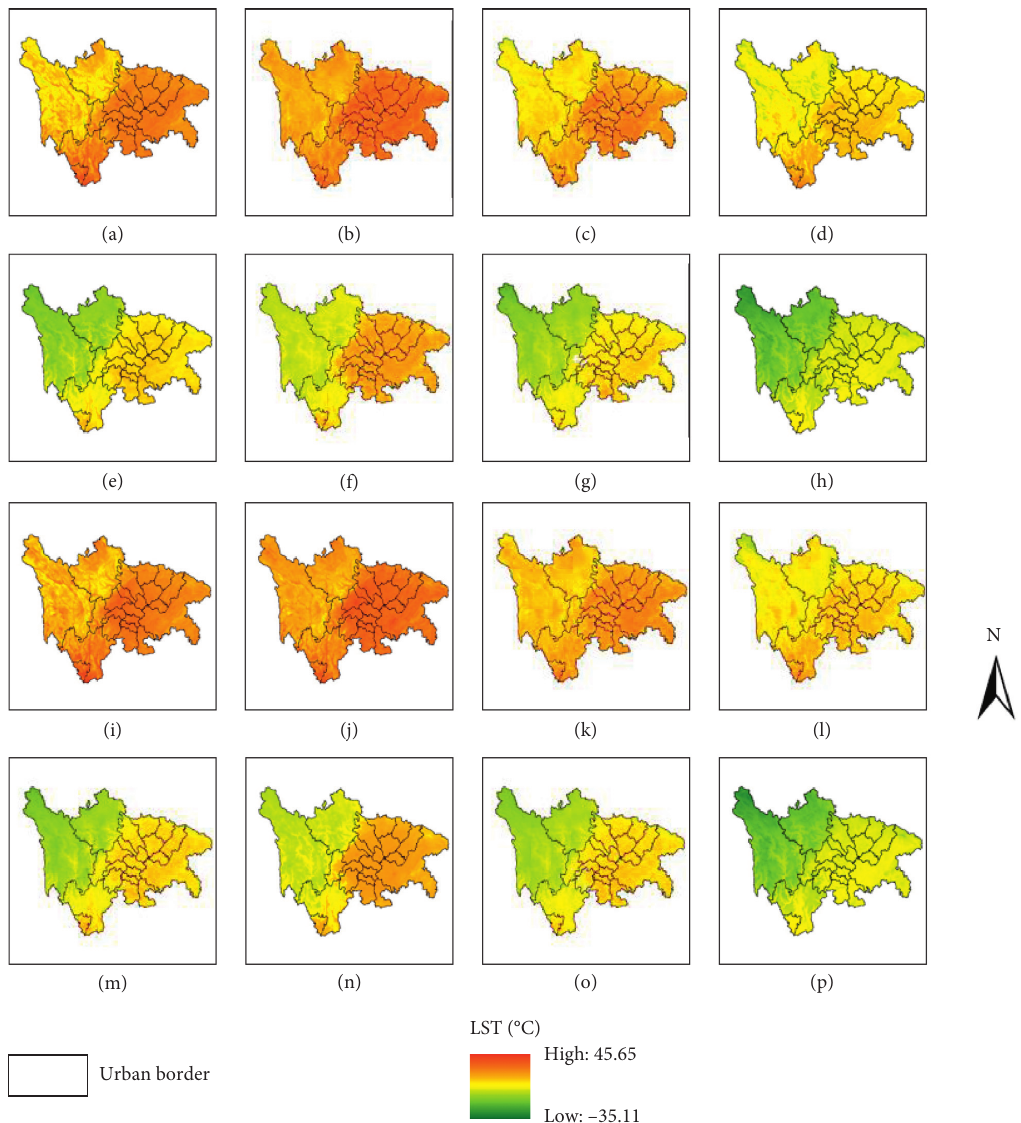
Figure 3: The spatial distribution of land surface temperature between 2005 and 2015 in Sichuan-Chongqing region. (a) 2005 spring daytime. (b) 2005 summer daytime. (c) 2005 autumn daytime. (d) 2005 winter daytime. (e) 2005 spring nighttime. (f) 2005 summer nighttime. (g) 2005 autumn nighttime. (h) 2005 winter nighttime. (i) 2015 spring daytime. (j) 2015 summer daytime. (k) 2015 autumn daytime. (l) 2015 winter daytime. (m) 2015 spring nighttime. (n) 2015 summer nighttime. (o) 2015 autumn nighttime. (p) 2015 winter